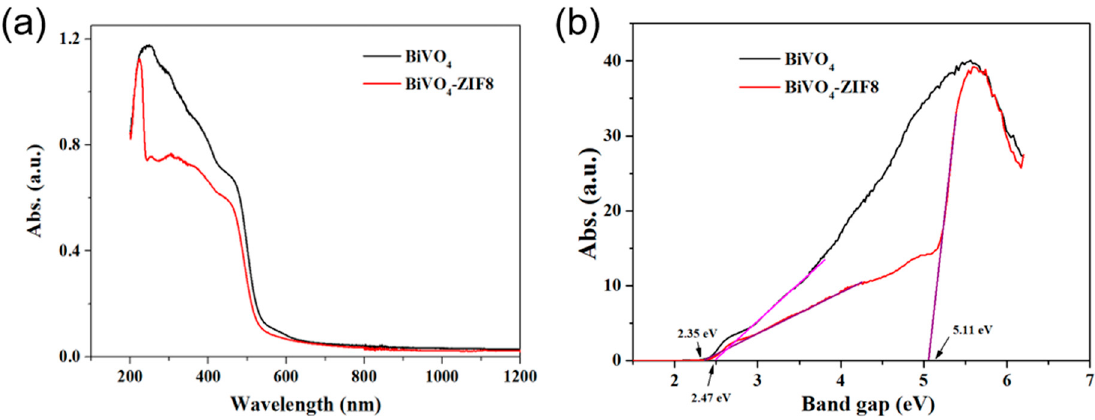
Figure 5. ( a ) The UV–Vis absorption curves of pure BiVO 4 (black) and BiVO 4 @ZIF − 8 (red); ( b ) the corresponding Kubelka–Munk (K–M) transformed curves of pure BiVO 4 (black) and BiVO 4 @ZIF − 8 (red). The band gaps for BiVO 4 @ZIF − 8 and pure BiVO 4 were calculated as 2.35 eV and 2.47 eV, respectively.